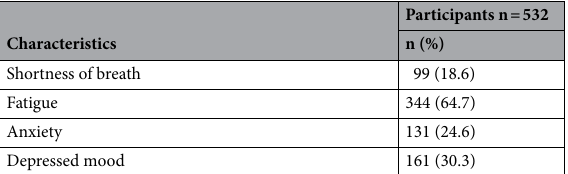
Table 1. Baseline characteristics and symptom burden of participants with advanced cancer, who filled out the cross-sectional symptom assessment survey. a Cancer site exceeds 100% because patients had more than one primary cancer site. b Other primary cancer sites: Bonemarrow, M. Kahler, multiple myeloma, bone, gallbladder, cholangiocarcinoma, small intestine, anal cancer, stomach cancer, basal skin carcinoma, squamous cell carcinoma of the skin, leiomyosarcoma, sarcoma, GIST, cervical cancer, vaginal cancer, mesothelioma. c Chemotherapy and/or hormone therapy and/or immunotherapy and/or other (intravenous immunoglobulin therapy, angiogenesis inhibitors, BRAF targeted therapy, unspecified targeted therapy). d Patient-reported